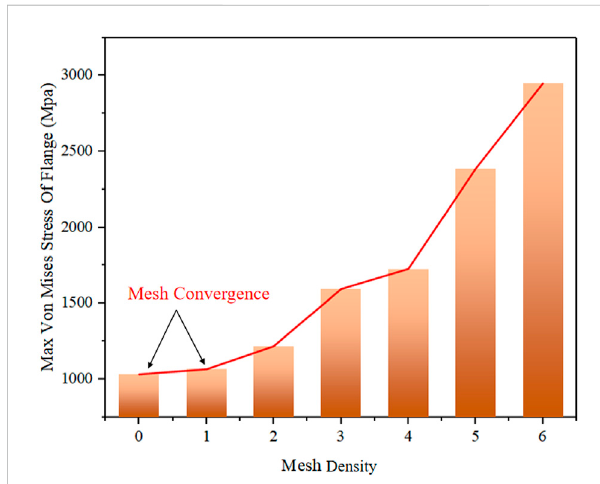
FIGURE 5 Maximum von Mises stress of the FOWTs ’ fl ange under different mesh